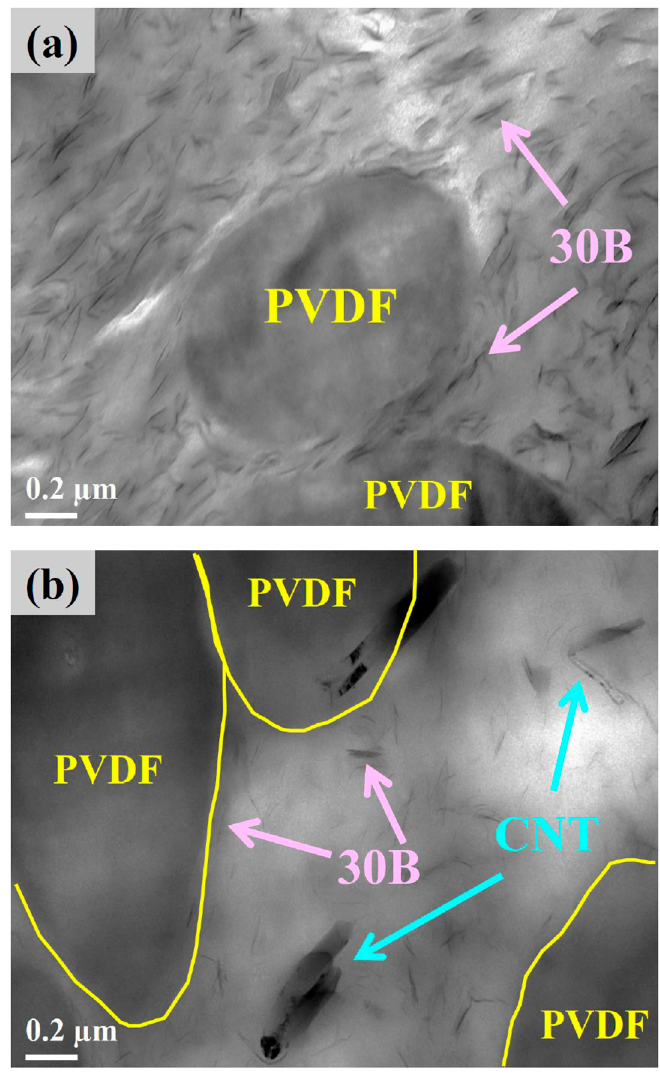
Figure 2. TEM images of ( a ) A5F5C2 and ( b ) A5F5C1T1.